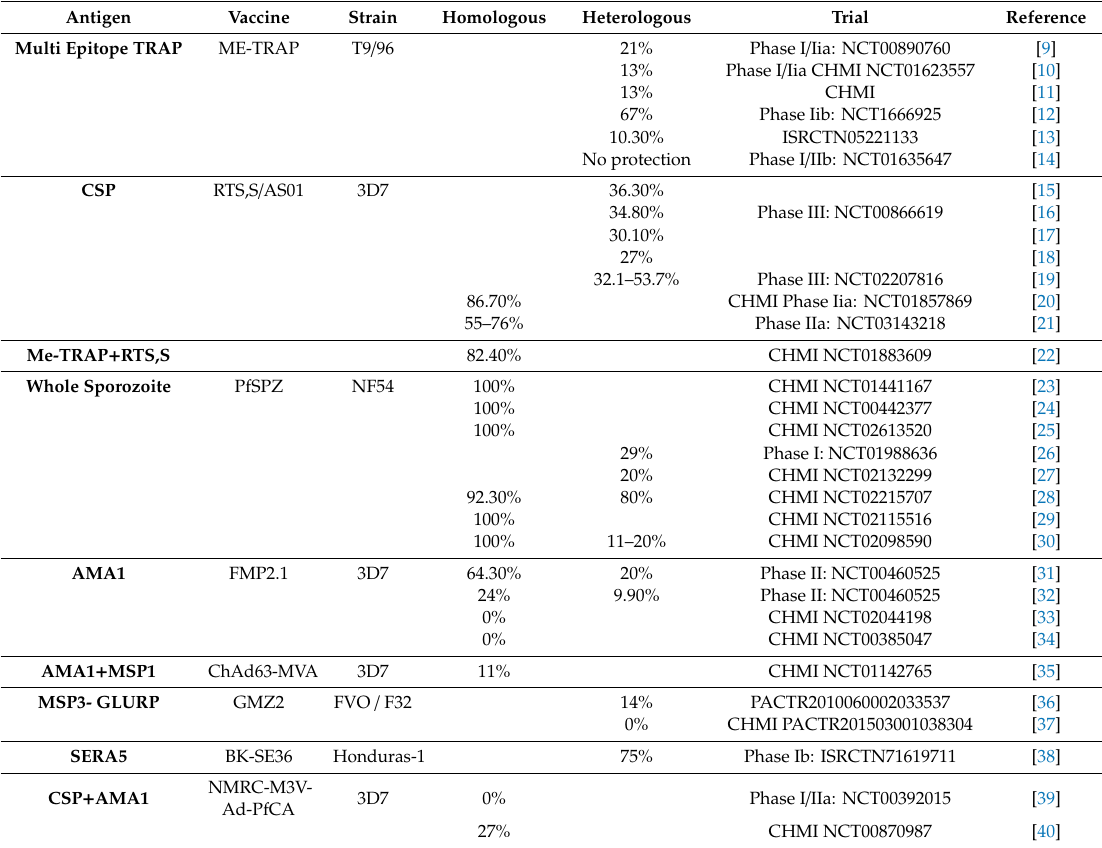
Table 1. Recent clinical trials of Plasmodium falciparum vaccines with e ffi cacy data available. Orange: pre-erythrocytic proteins; red: whole sporozoite vaccines; green: blood stage proteins; blue: multi-stage